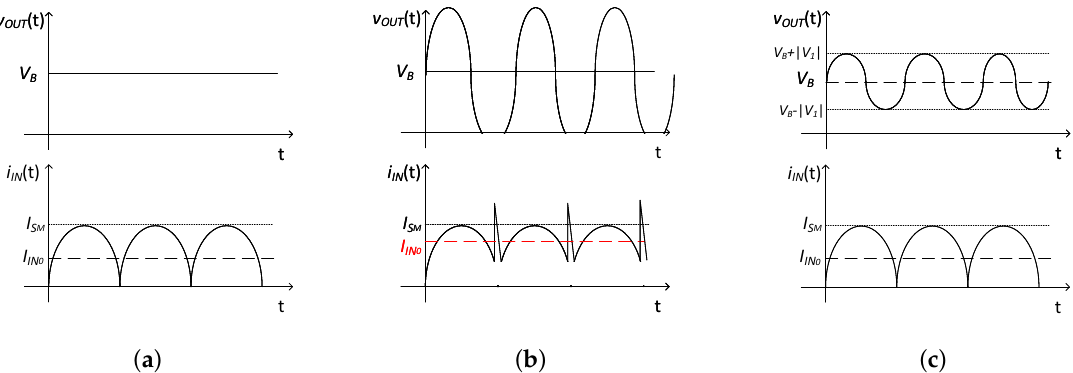
Figure 3. Secondary filter waveforms. Battery voltage v OUT and filter current i IN working in: continuous-mode with no voltage ripple (large C 0 ) ( a ); discontinuous-mode ( C 0 = C ∗ ) ( b ); continuous-mode ( C 0 = C ∗ ) ( c